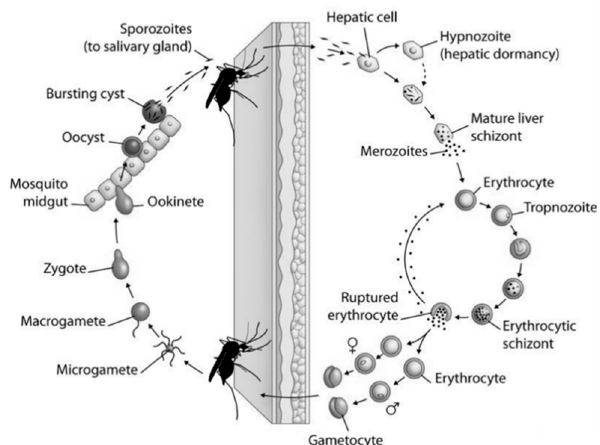
Figure 1. When a mosquito bites a human (host for malarial parasite) it causes infection by injecting sporozoites into the body, where it adversely affects hepatocyte’s shape. Sporozoites grow rapidly in hepatocytes to become merozoites, while merozoites grow rapidly causing hepatocytes to burst and infect neighboring hepatocytes. When a mosquito bites the malaria patient the gametocytes that are produced from merozoites are taken by a mosquito. For the next 10 to 14 days the gametocytes produce sporozoites which are transferred to the saliva gland waiting for a mosquito to bite a healthy person and cause infection.